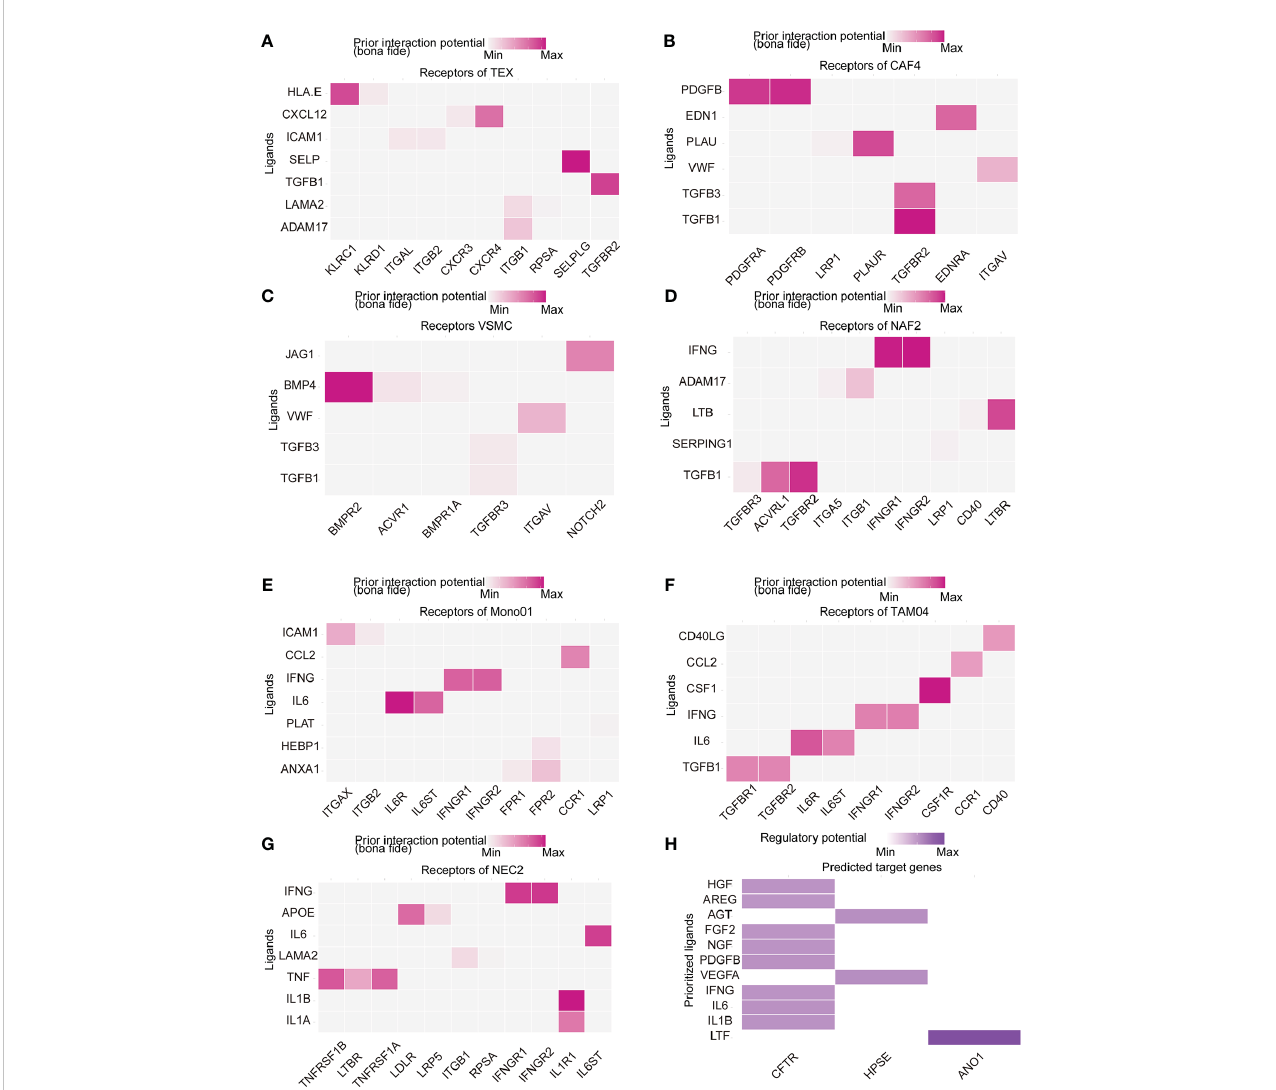
FIGURE 6 Cell – cell communications result. (A – G) Heatmap visualizing NicheNet analysis of receptors of prioritized ligands expressed by (A) exhausted T (TEX) cells, (B) cancer-associated fi broblasts (CAF4) cells, (C) vascular smooth muscle cells (VSMC), (D) normal activated fi broblasts (NAF2), (E) tumor- associated macrophages (TAM03), (F) monocytes (Mono01), and (G) normal endothelial cells (NEC2). (H) NicheNet analysis of ligand-receptor interactions of